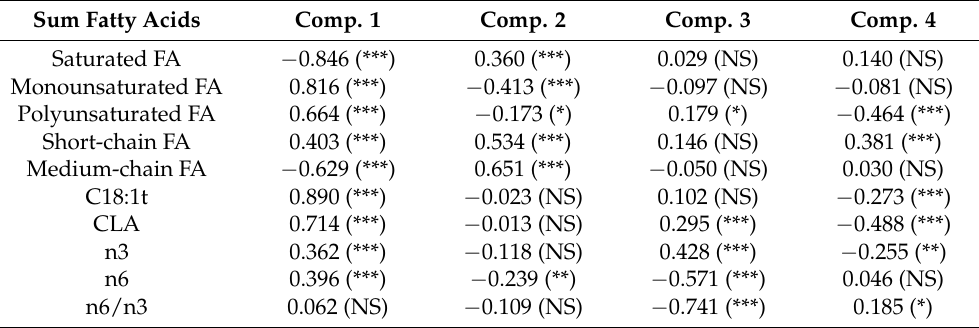
Table 5. Pearson correlation and the two-tailed level of significance of the sum fatty acids (FA) with the expressed factor scores of the four components of Table